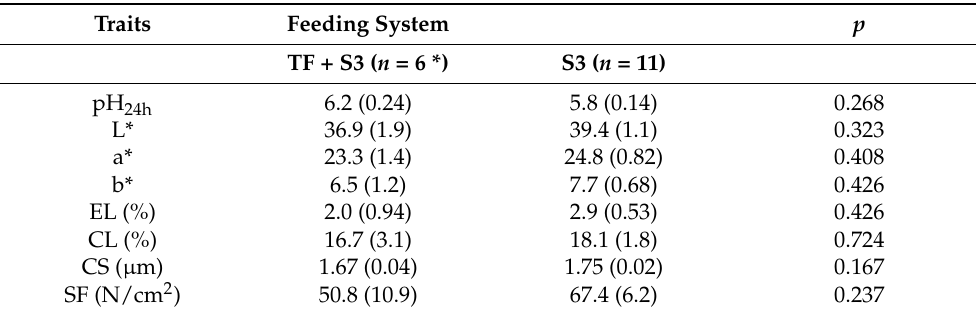
Table 5. Least square means and standard errors (in parenthesis) for meat quality traits for steers from TF + S3 and S3 finishing